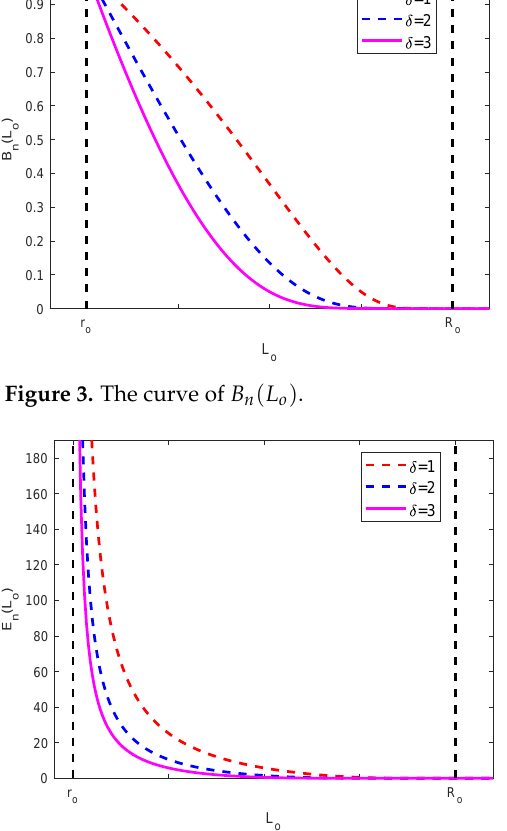
Figure 4. The curve of E n ( L o )